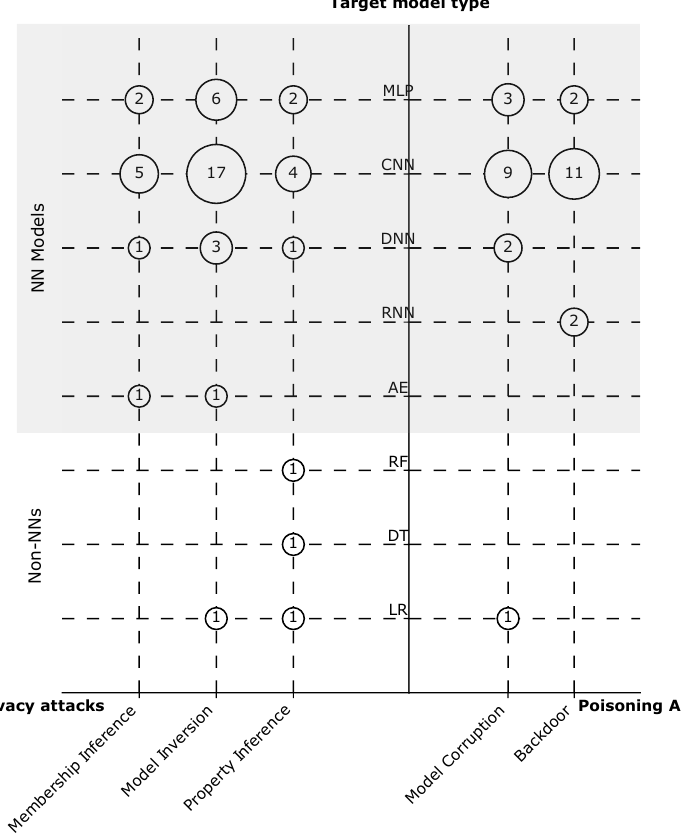
Figure 11. Bubble chart that shows the papers’ distribution in two dimensions: attack purpose and target model. We see a very low frequency of all attack types on non-NN models. Additionally, NN models such as Recurrent Neural Network (RNN) and Autoencoder (AE) receive little attention from various